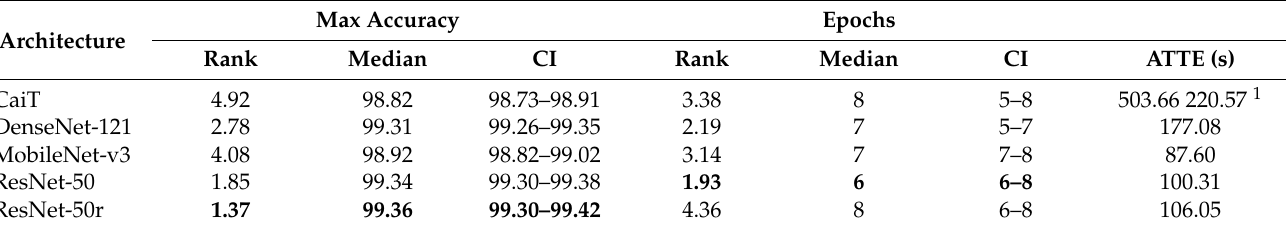
Table 12. Ranking of the maximum training accuracy and training epochs, medians and confidence intervals (CI) by architecture with α = 0.05 and Average training time per epoch (ATTE). Best results are highlighted in